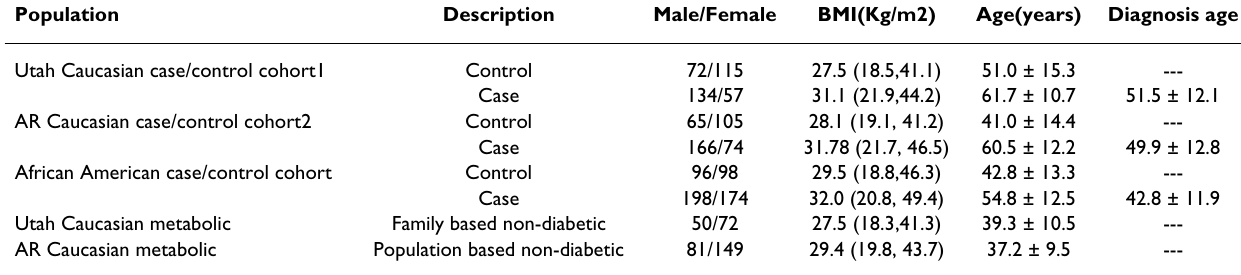
Table 1: Summary of Study Populations Population